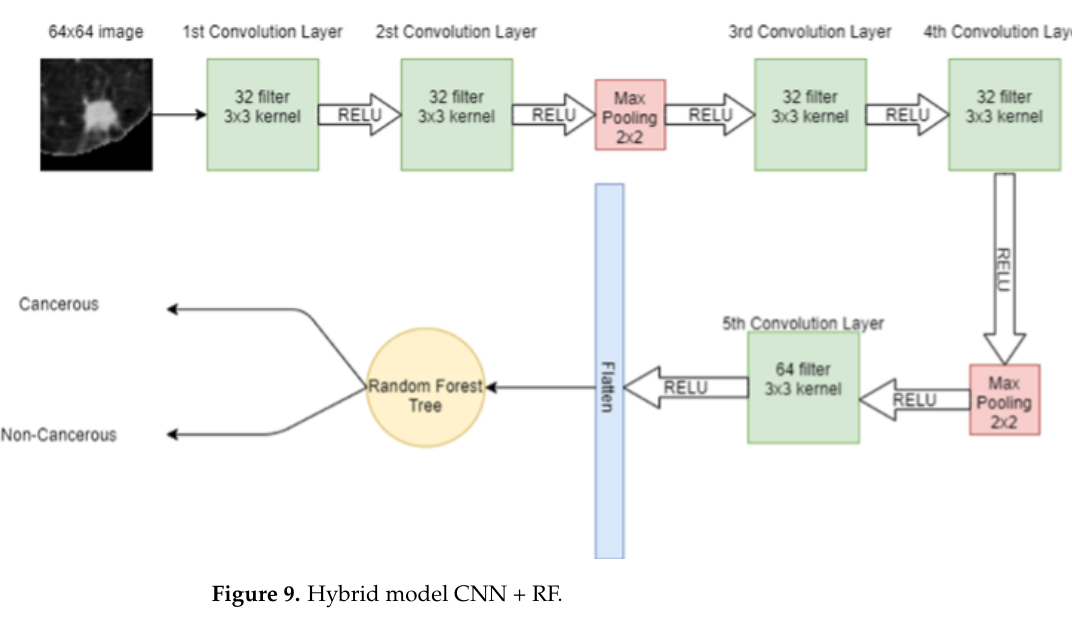
Figure 9. Hybrid model CNN +